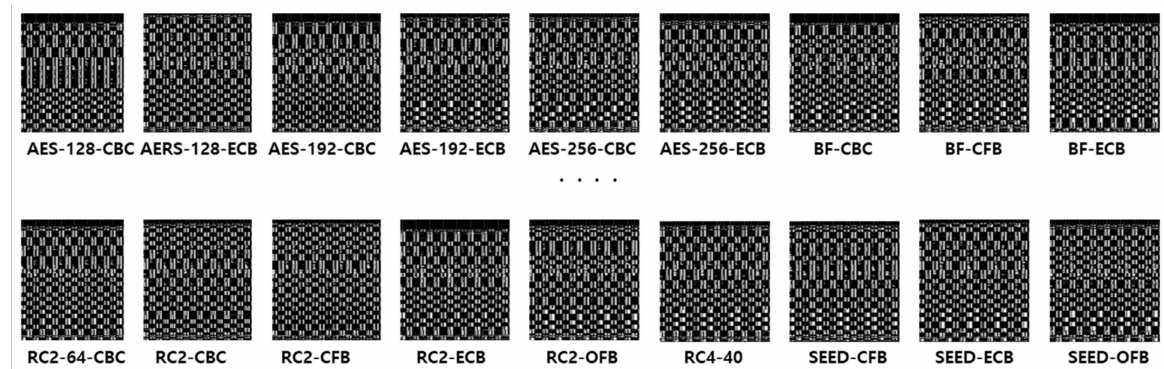
Figure 8. Image of symmetric-key algorithm in the first data set.